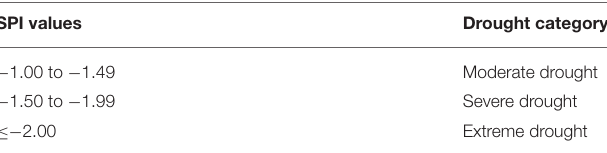
TABLE 1 | Drought categories for SPI (WMO—World Meteorological Organization, 2012). SPI